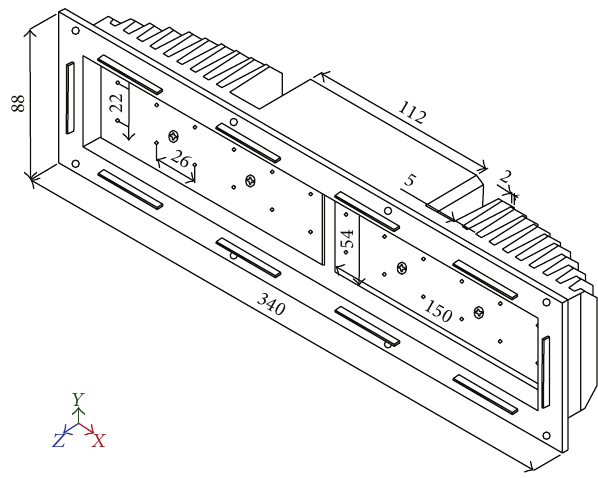
Figure 1: LED illumination